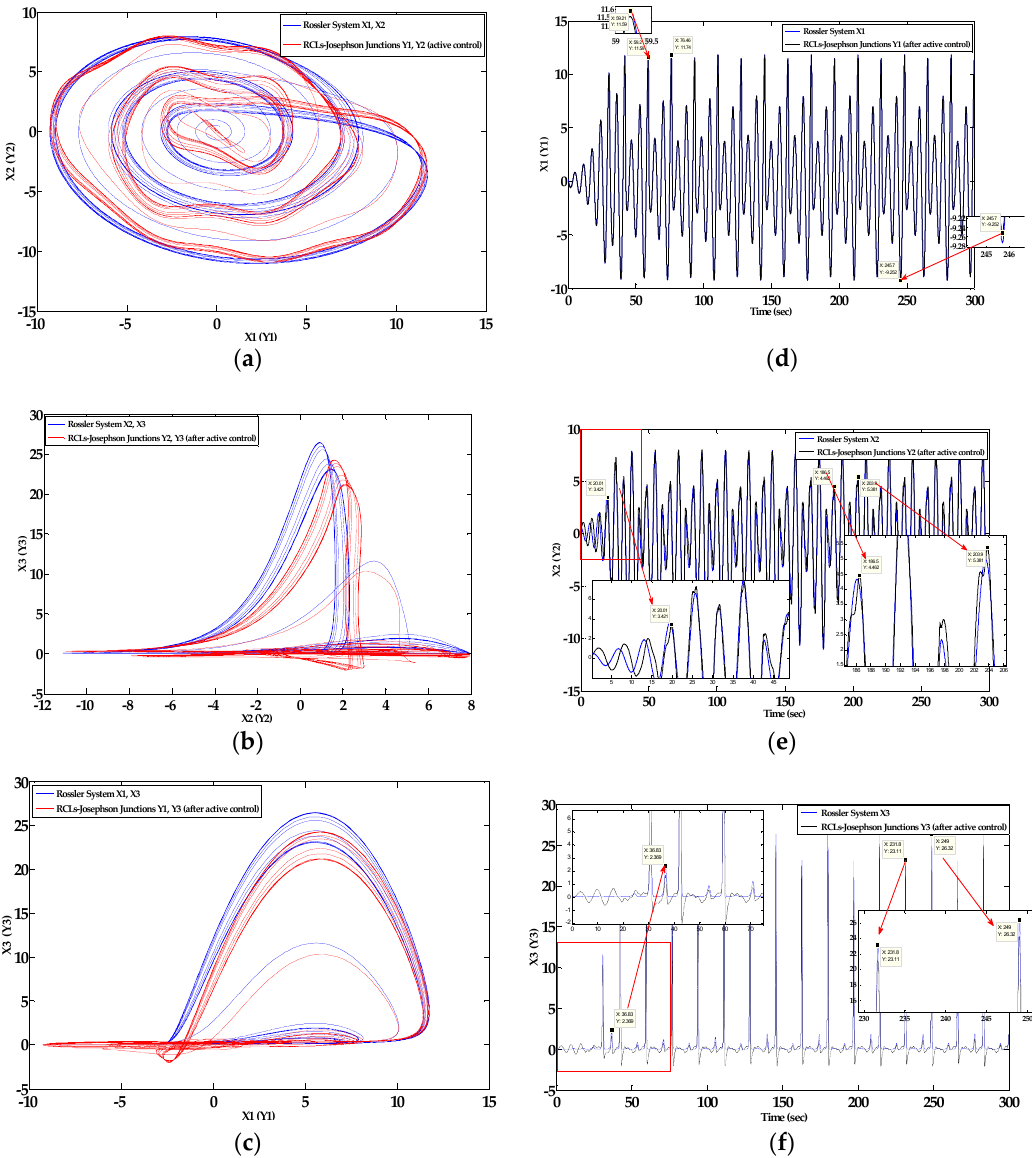
Figure 2. Original phase portrait of the Rossoler system with (cid:4670)(cid:1876) (cid:2869)(cid:2868) (cid:1876) (cid:2870)(cid:2868) (cid:1876) (cid:2871)(cid:2868) (cid:4671) (cid:3021) = (cid:4670)0.2 0.4 0.1(cid:4671) (cid:3021) in the left column, ( a ) the Rossoler system x 1 , x 2 , ( b ) the Rossoler system x 2 , x 3 , and ( c ) the Rossoler system x 1 , x 3 , and the original phase portrait of the RCL-shunted Josephson Junction system with an initial condition at the original in the right column, ( d ) the RCLs-JJ system y 1 , y 2 , ( e ) the RCLs-JJ system y 2 , y 3 , and ( f ) the RCLs-JJ system y 1 , y 3 .